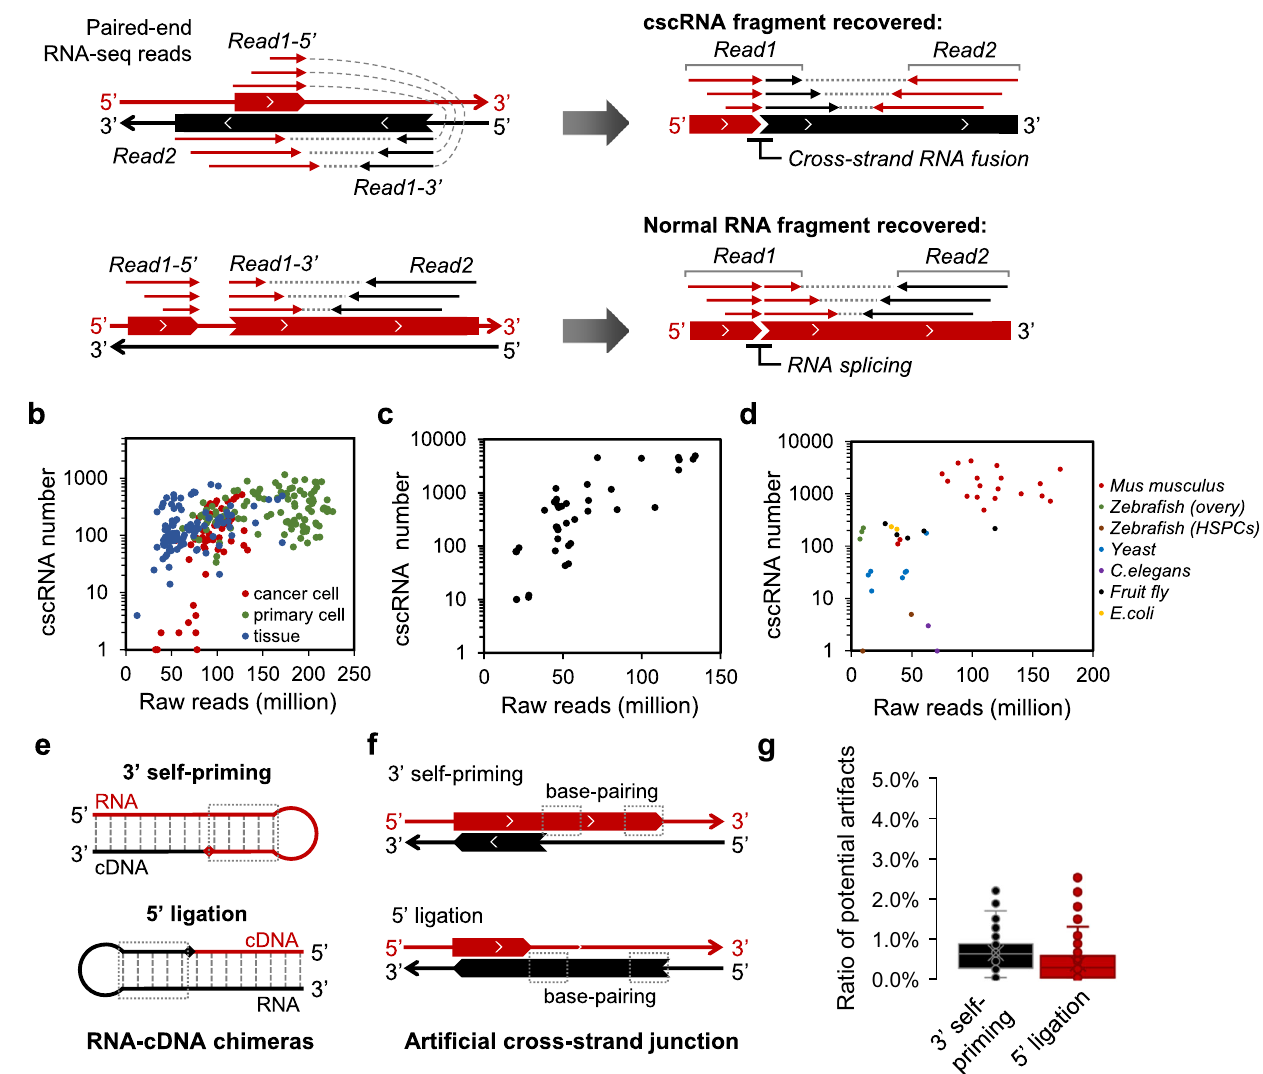
Fig. 1 Identi fi cation of the cscRNAs with total RNA PE sequencing datasets. a Alignment scenarios of the PE RNA-seq reads for identi fi cation of the cross-strand RNA fusion events (top) and the regular exon – exon junctions upon RNA splicing (bottom). Top: one end (e.g., read1) of the PE reads were truncated into two fragments, which were mapped to the two opposite reference strands, respectively. The other end (read2) was then mapped to the shifted strand accordingly. Bottom: one end (e.g., read1) of the PE reads were truncated into two fragments, which were mapped to two positions of the same strand, indicating an exon – exon junction upon RNA splicing. The other end (read2) was mapped to the same strand. b The numbers of cscRNAs identi fi ed in each of the human RNA-seq datasets from ENCODE, including 54 samples of cancer cell lines, 109 samples of primary cells, and 108 samples of normal tissues. The raw read number of each dataset is shown on the X axis. c The numbers of cscRNAs identi fi ed in each of the human RNA-seq datasets from the GEO database. The raw read number of each dataset is shown on the X axis. d The numbers of cscRNAs identi fi ed in the datasets of multiple other species, including mouse (20 samples), zebra fi sh (5), C. elegans (6), fruit fl y (5), yeast (7), and E. coli (2). The datasets of mouse are from ENCODE, and all the others are from the GEO database. The raw read number of each dataset is shown on the X axis. e Potential artifacts during reverse transcription due to 3 ′ self-priming (top) of the template RNA or 5 ′ ligation (bottom) between the template RNA and the cDNA, both of which generate RNA – cDNA chimeras. f Arti fi cial cross-strand junction events recovered by the RNA-seq reads of the RNA – cDNA chimeras shown in ( a ). The dashed boxes illustrate the reverse-complementary regions on the same strand, which strongly indicate the potential artifacts during reverse transcription as shown in ( a ). g Box plots illustrating the percentages of the potential arti fi cial cscRNAs that show signatures of 3 ′ self-priming or 5 ′ ligation, in the 271 human samples from ENCODE. As shown in ( b ), base-pairing for at least 4 bp in the upstream fragment is deemed as a sign of 3 ′ self-priming, whereas base-pairing in the downstream fragment is a sign of 5 ′ ligation. The distance between the base-pairing regions was set to be within 100 nt. The median value is shown as the line and the average as the cross. Source data are provided as a Source data fi combined. Among them, 3013 cscRNAs are recurrent in at least 21 samples all support the same event of cross-strand junction. two samples. For each of these recurrent cscRNAs, the same All the RNA-seq reads aligned to the two strands around the cross-strand junction event takes place in multiple samples, all cross-strand junction sites of cscR-2-1are shown in Fig. S2. between exactly the same pairs of the nucleotide sites. Taking cscR-2-1 as an example, in total, 101 RNA-seq PE reads in